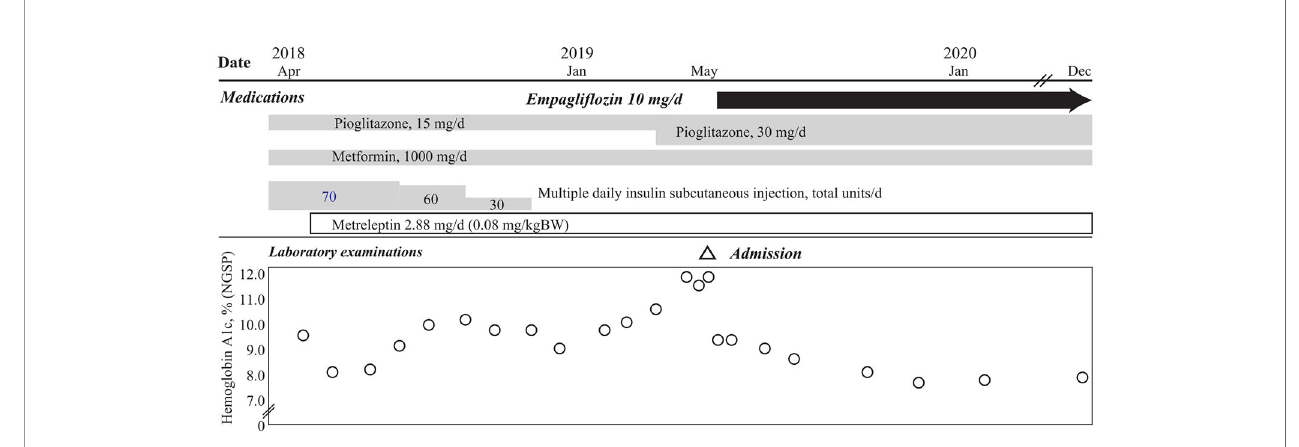
FIGURE 1 | Clinical course of the patient in this case. Hemoglobin A1c levels of the patient in this case show rapid reduction after oral administration of empagli fl ozin, with continuation of 15 mg/day pioglitazone and 1000 mg/day metformin, and 2.88 mg/day of subcutaneous metreleptin supplementation, with termination of insulin injection. The HbA1c level is maintained at ~8.0%, 18 months after empagli fl ozin